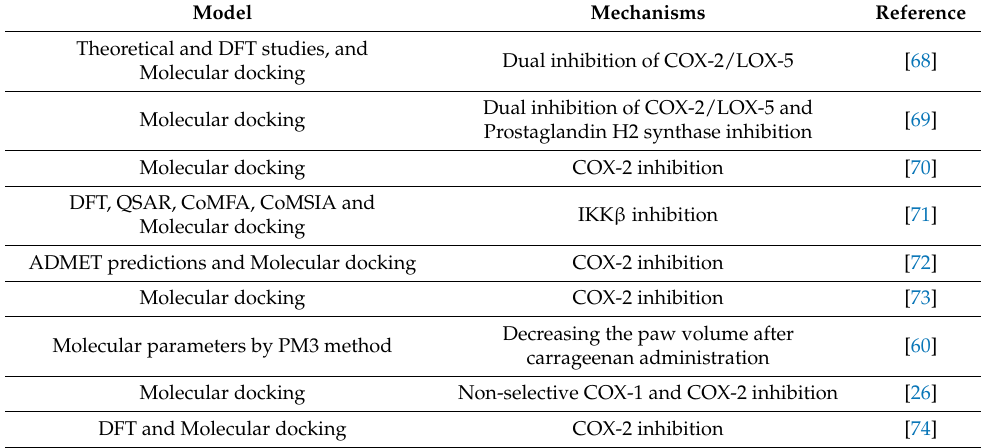
Table 4. Summary of the predictions from in silico studies performed with thiophene-based com- pounds with potential anti-inflammatory activity.